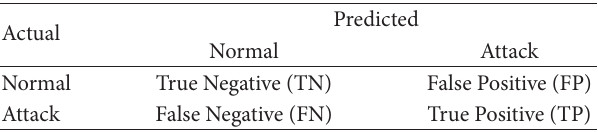
Table 7: Confusion